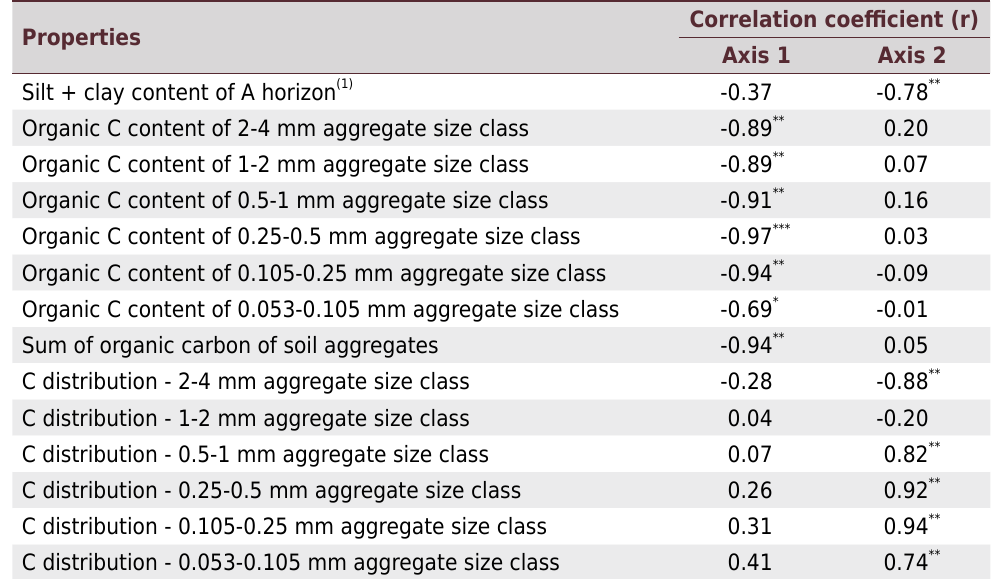
Table 8. Pearson correlation coefficients between C aggregate size classes properties (0.00-0.08 m soil layer) and non-metric multidimensional scaling (NMS) axes (Figure 3)